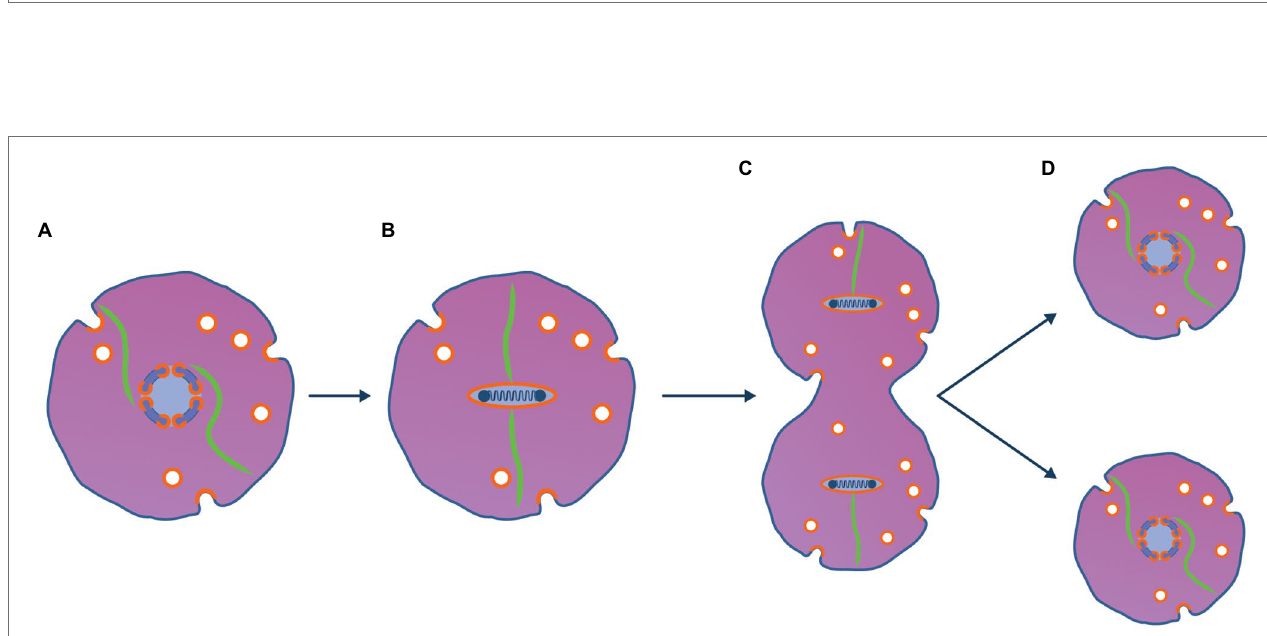
FIGURE 2 | Viral colonisation of the Archaeal host introduces multiple “eukaryotic” features in a single saltational event. The virus genome enters the host archaeon by fusing its internal membrane with the host membrane using an ancestral HAP2 fusogen homologue. As observed with Sulfolobus infections, the virocell may have become significantly enlarged upon viral infection due to modification of the host’s cell cycle and ESCRT system (Liu J. et al., 2021). The virus establishes a viral factory protecting the viral genome from host defence mechanisms and introduces an uncoupling of transcription from translation. Viral ‘protocoatamers’ sharply bend membranes producing clathrin-like pits that break off to form ‘coated vesicles’ for constructing new virions ( cf. Hong et al., 2014). The protocoatamers are also used to construct pores in the viral factory allowing controlled transport of proteins and RNA in and out of the viral factory. Tubulin encoded by the virus forms a dynamic cytoskeleton that positions the viral factory in the centre of the cell (Chaikeeratisak et al., 2017). The coated vesicles are treadmilled along the tubulin cytoskeleton towards the viral factory where the virions are assembled (Chaikeeratisak et al., 2019) and DNA is condensed on nucleosomes and packaged into the virion. Protocoatamer constructed vesicles allow egress of virions through the plasma membrane without disrupting the plasma membrane.